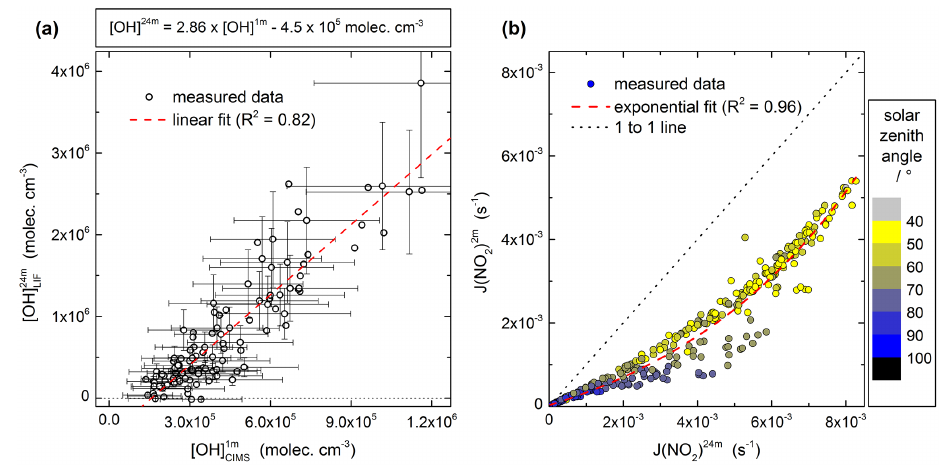
Figure 2. (a) The linear correlation of OH concentration below and above the canopy was used for interpolating data of OH concentration above the canopy. (b) Similar to (a) , the exponential correlation of measured photolysis frequency below and above the canopy was used to interpolate data of J (NO 2 ) below the canopy. Colour code of dots represents the solar zenith angle. Additionally, the one-to-one line is shown as a dashed line.